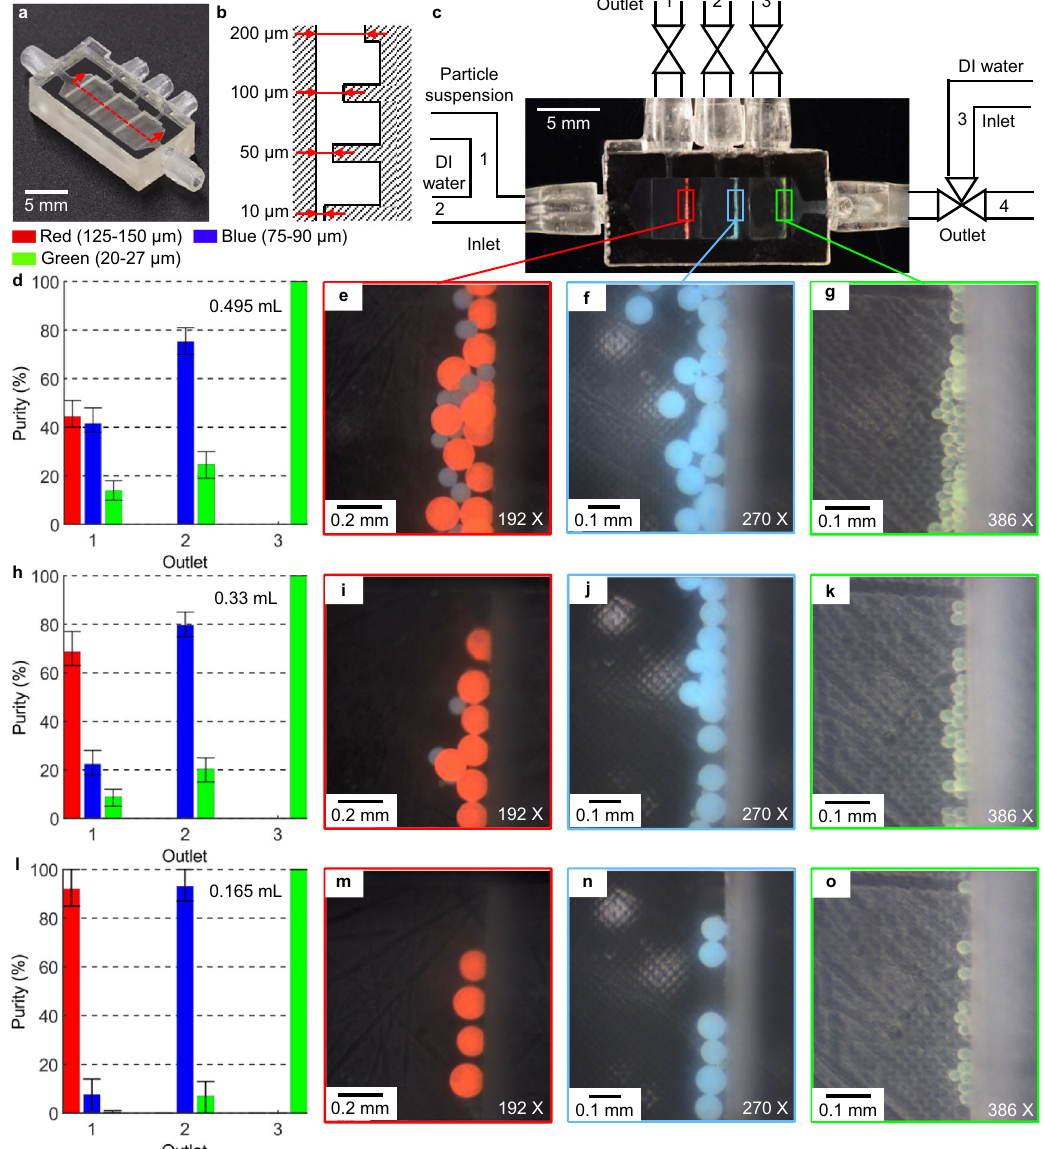
Fig. 5 3D-printed microparticle sorting device. a Fabrication result of the micro fi lter chip (isometric view). b Schematic drawing illustrating the interior of the micro fi lter chip (not to scale, side sectional view). c Illustration of the working principle of the microparticle sorting system (top view). d – o Particle sorting behaviors with different doses. d , h , i Purity of the particles from each outlet. e – g , i – k , m – o Microscope images showing the sorted microparticles in each micro fi lter